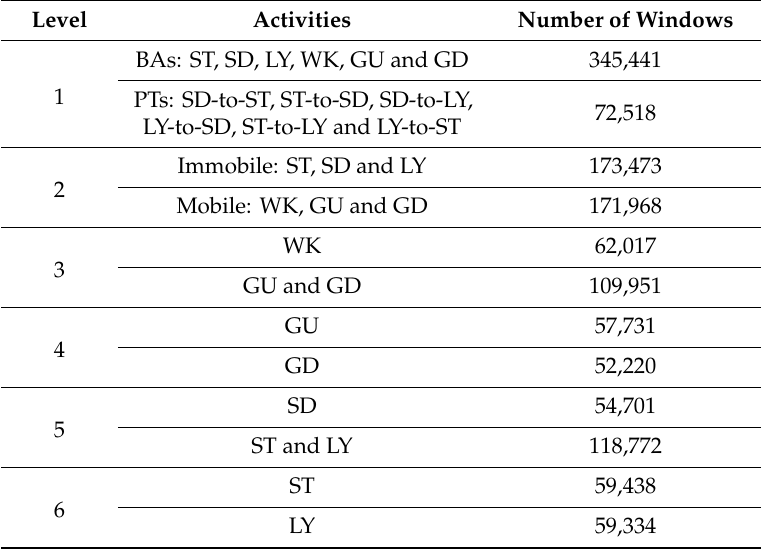
Table 6. Class distributions at each